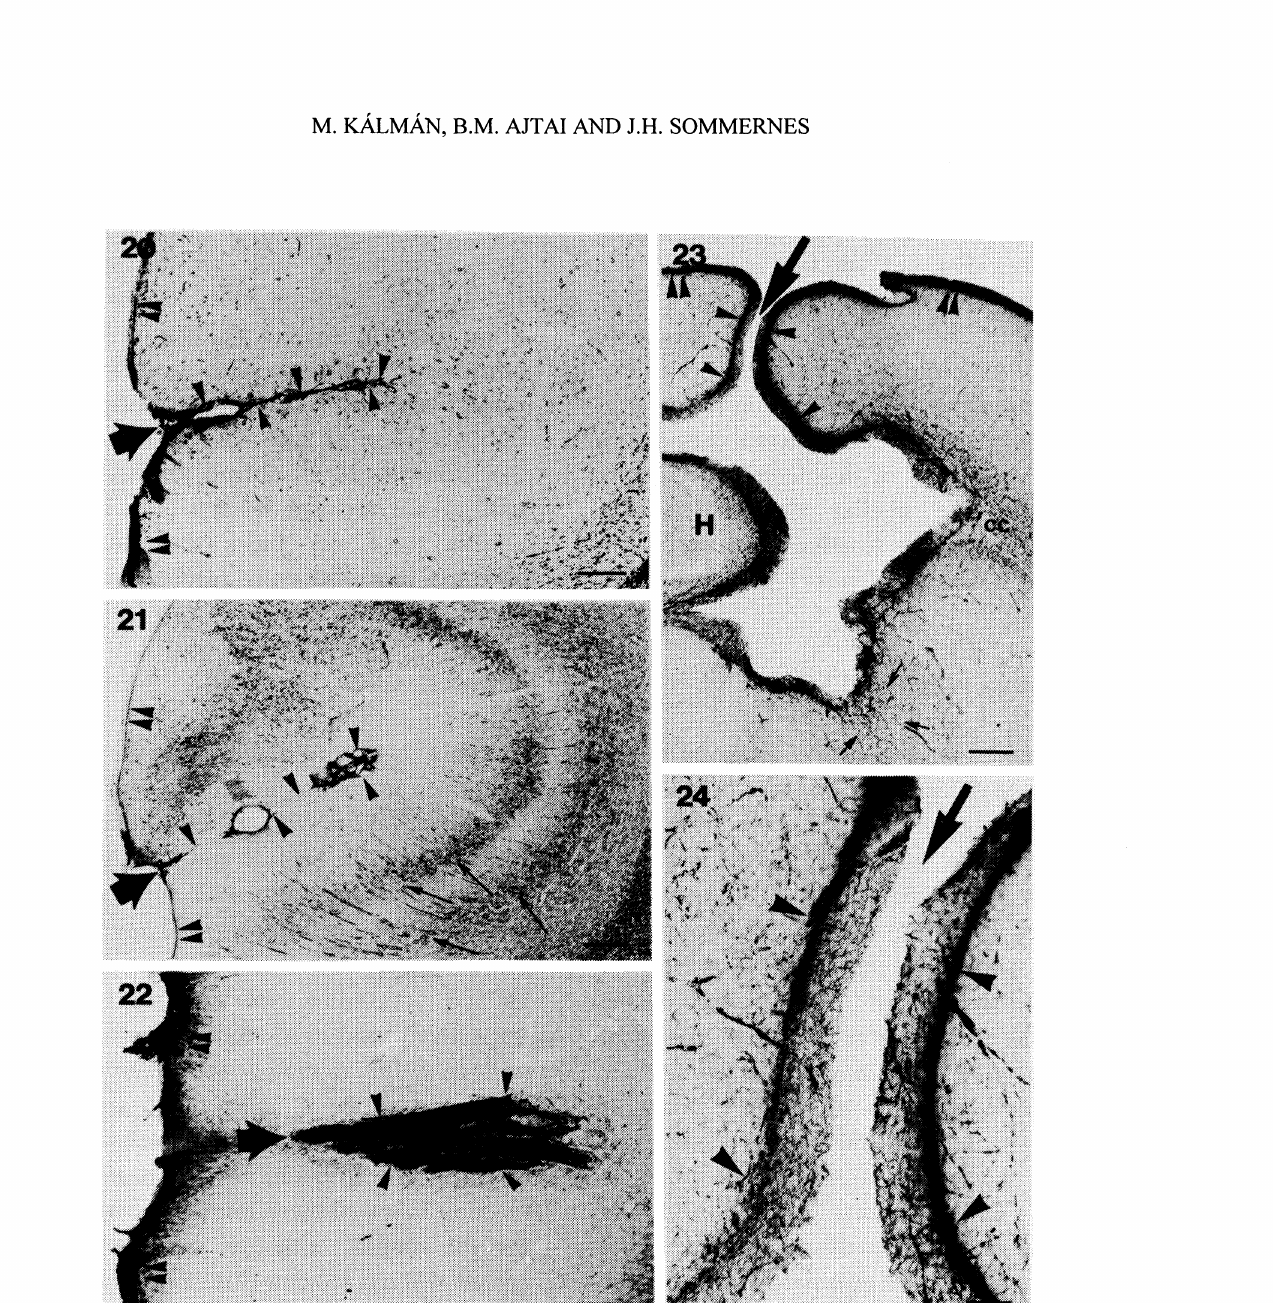
Figs. 20-24: GFAP immunostaining of severe-type lesions. (20) El9 lesion, post-op d-14. A deep cortical invagination (thick arrow) marks the site of the lesion. No reactive glia can be found. The glia along the surface of the lesion (arrow- heads) are similar to that seen below the intact surface of the cortex (double arrowheads). Bar 180 gm. (21) El9 lesion, post-op d-14. A section parallel to that shown in Fig. 20, but after neurofilament staining. Along the lesion (thick arrow) the cortical layers (thin arrows) follow the invaginated brain surface (arrowheads). Bar 180 lam. (22) E20 lesion, post-op d-14. Here the lesion inserted a piece of meningeal tissue (large arrow) into the cortex. The glia along this meningeal tissue (arrowheads) are similar to those seen below the intact surface of the cortex (double arrowheads). Bar Reactive glia are found in the diencephalon (arrows), but not in the cortex. The glia along the surface of the lesion (arrowheads) are similar to those seen below the intact surface of the cortex (double arrowheads). H hippocampus, CC corpus callosum. Bar 500 lam. (24) Enlarged detail of Fig. 22. The glia lining the surface of the lesion (arrowheads) are not reactive glia. Bar 80